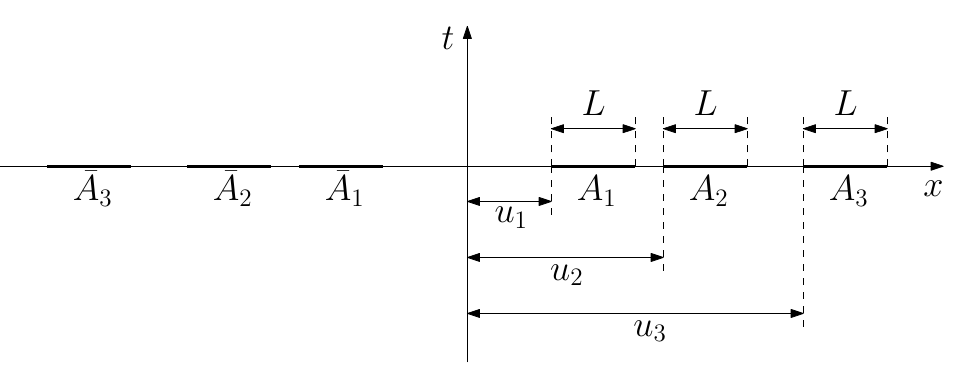
Figure 1 . The family of regions considered consists of intervals A i that are obtained by mak- ing arbitrary positive translations of the fundamental interval (0 ; L ), and their wedge re(cid:13)ected counterparts (cid:22) A i . In the (cid:12)gure we see three di(cid:11)erent translations of the fundamental interval with parameters u 1 , u 2 and u 3 . The distance between the region A i and (cid:22) A j is just u i + u j .